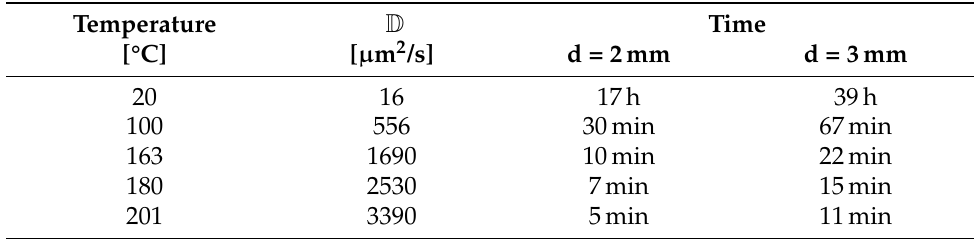
Table 1. Diffusion coefficients D and calculated diffusion times until equilibrium vs. temperature for an oil/Styrene-Butadiene Rubber (SBR) system according to Bouvier and Gelus [16]. Temperature